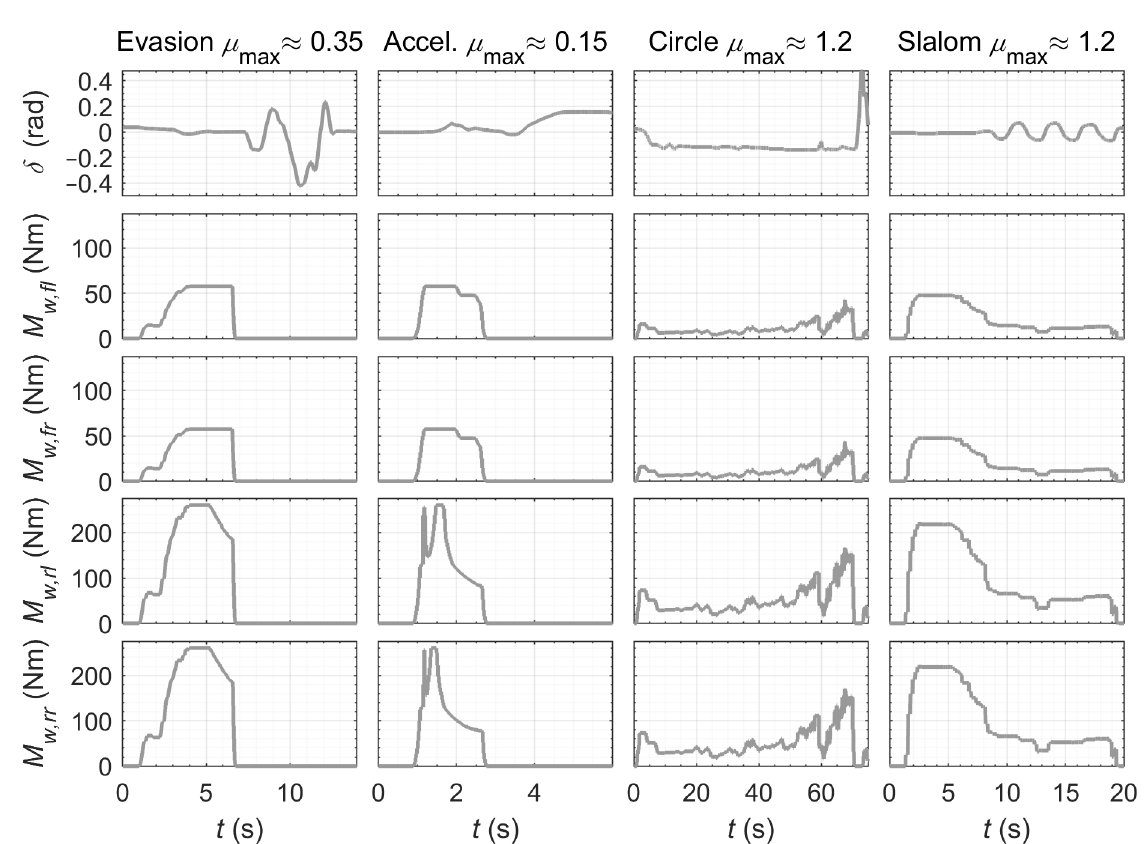
Figure A4. Test data: system inputs steering angle and motor torques.